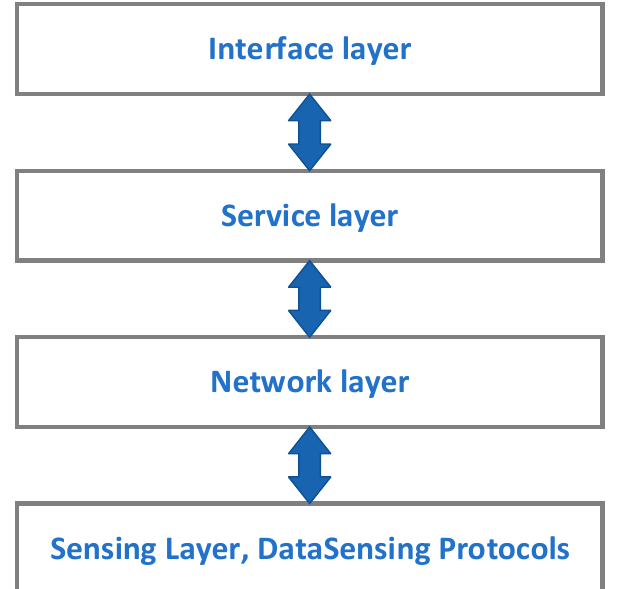
Figure 1. The service-oriented architecture of the Internet of Things [37].